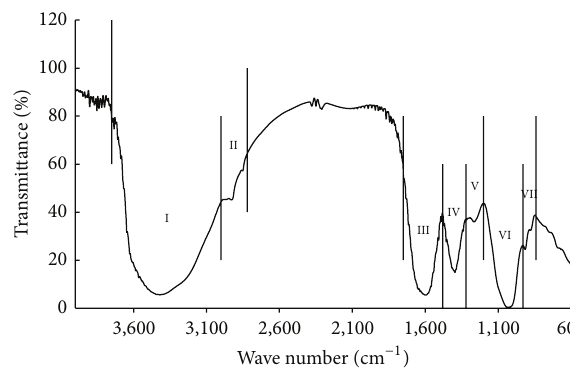
Figure 1: Schematic diagram with partition method of functional traits of GRSP by using infrared spectrum. Note: functional trait I (wave number of 3750–3000 cm −1 ) is a mixture of O–H stretching of carboxylic acid, phenols, alcohols, clay minerals and oxides, N–H stretching of organic amines, amides, and aromatic C–H